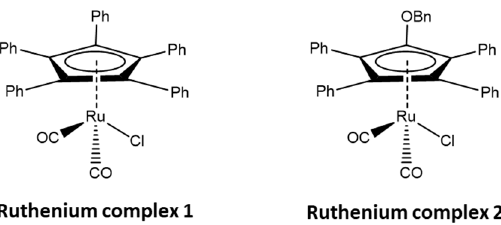
Figure 2. Ruthenium complexes [Ru(1)] and [Ru(2)] used in this study, Bn is the -CH 2 Ph group.